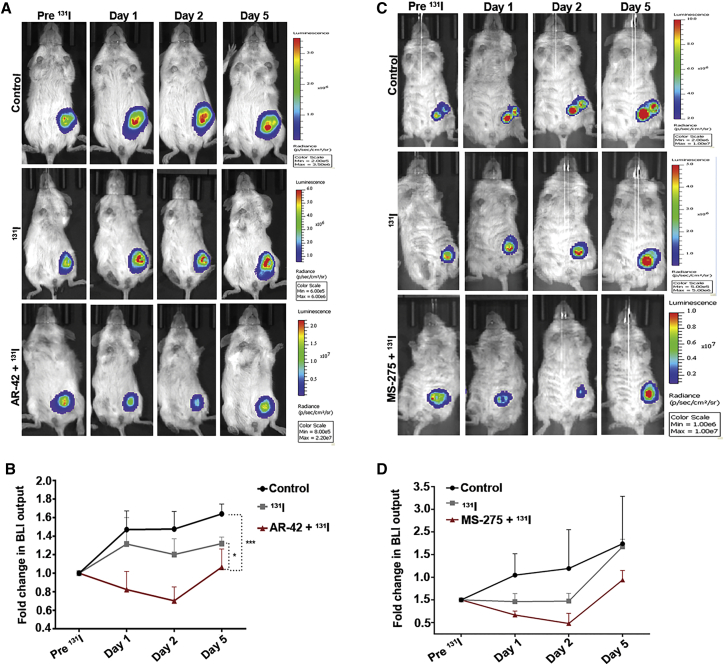
NIS-Mediated Radio-iodine Therapy Is Augmented in the Presence of AR-42 and MS-275 in BC(A and C) Panel of representative mouse images showing BLI signal from orthotopic ZR-75-1 (CMV-Fl2.Turbo) model. The change in BLI signal over 5 days after are shown for control, 131I only, and (A) AR-42 + 131I or (C) MS-275 + 131I groups as marked. (B and D) Graphs indicating the fold difference of quantified BLI signal for each with respect to the signals before 131I administration. Error bar indicates SEM calculated from three mice/group.